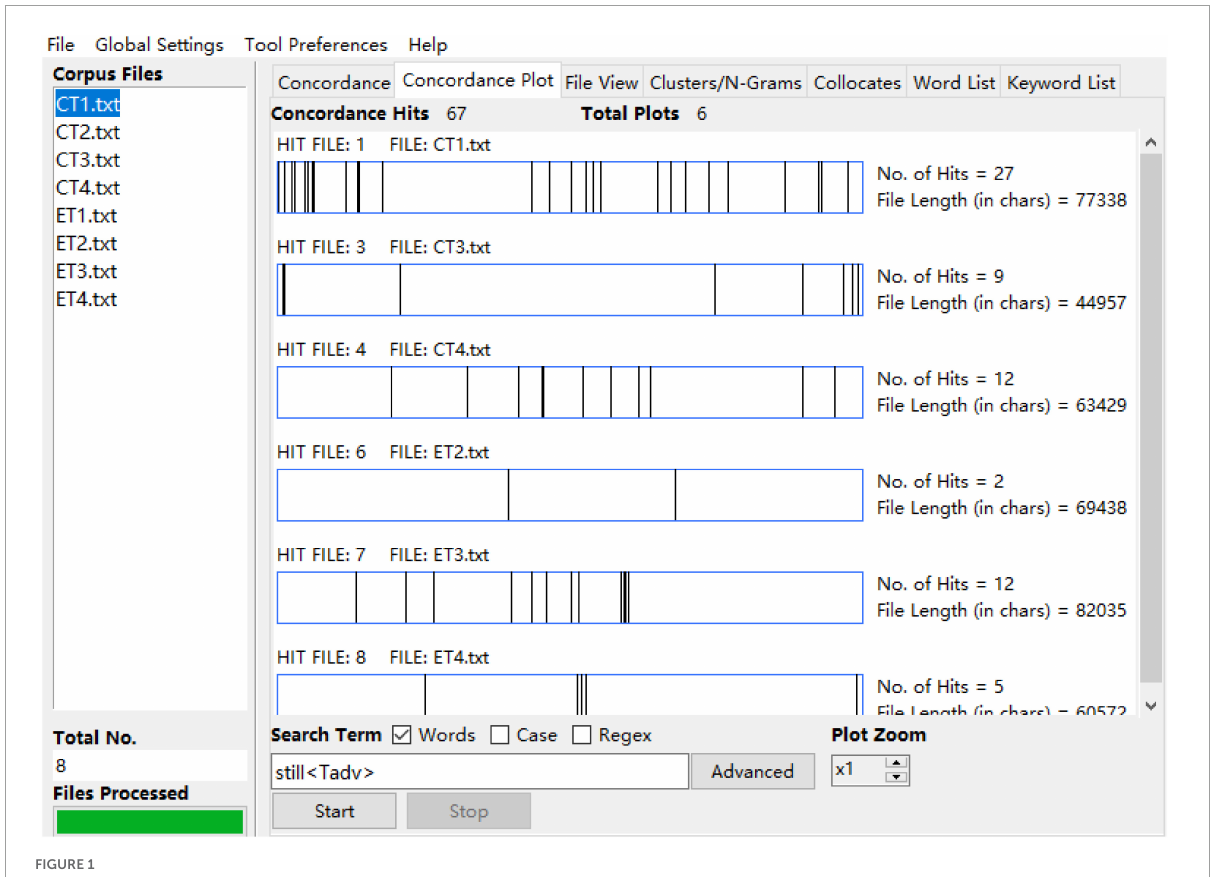
FIGURE1 Distribution of metadiscourse marker of still in AntConc.